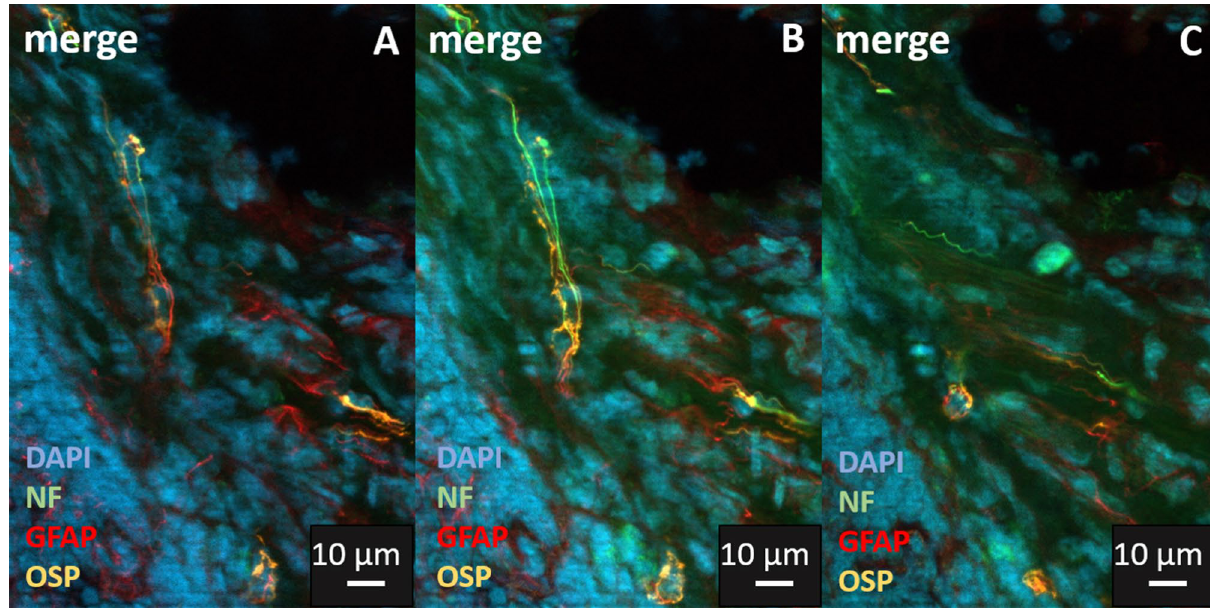
Figure 13. Lymph node co-stained with polyclonal anti-GFAP antibody (DAKO) in red and oligodendrocyte specific Marker (OSP) in orange, neurofilament (NF) marker in green and DAPI for nuclear staining in blue. The images from A to C show 3 different successive z levels. In image( A ) the majority of the signal of the centrally located cell is in red (GFAP). The neurofilament signal appears to be tightly connected with the processes of the cell. This is followed in ( B ) by a comprehensive filamentous Oligo signal, which is also associated with the neurofilament. ( C ) The presumably deep cell nucleus of this cell with the surrounding double-positive signals for GFAP and